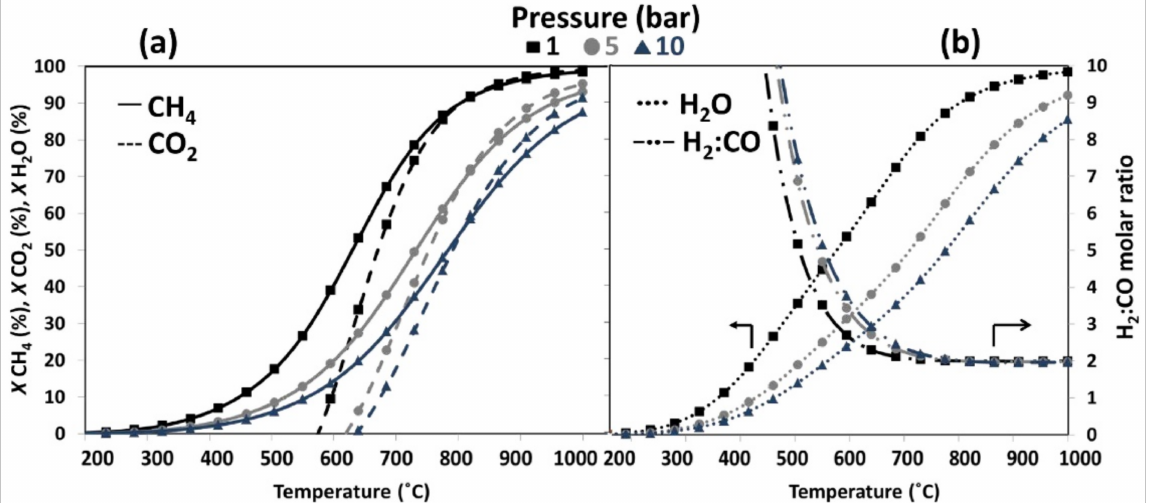
Figure 4. Thermodynamic equilibrium plot for POM as a function of temperature (T = 200–1000 ◦ C) at 1–10 bar with CH 4 :CO 2 :H 2 O = 3:1:2. ( a ) CH 4 and CO 2 conversion levels; ( b ) H 2 O conversion and H 2 /CO ratio profile. Reprinted with permission from [135]. Copyright 2020